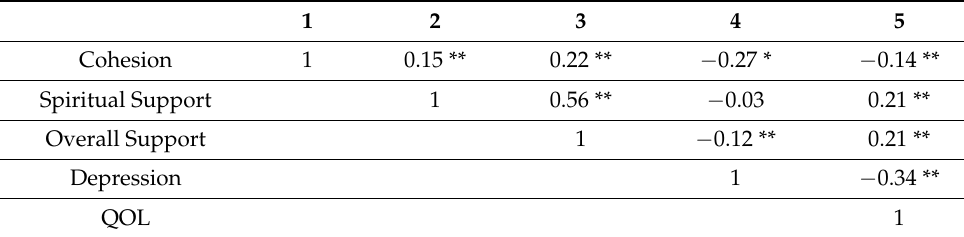
Table 1. Bivariate correlations between cohesion, social support, and health outcomes.